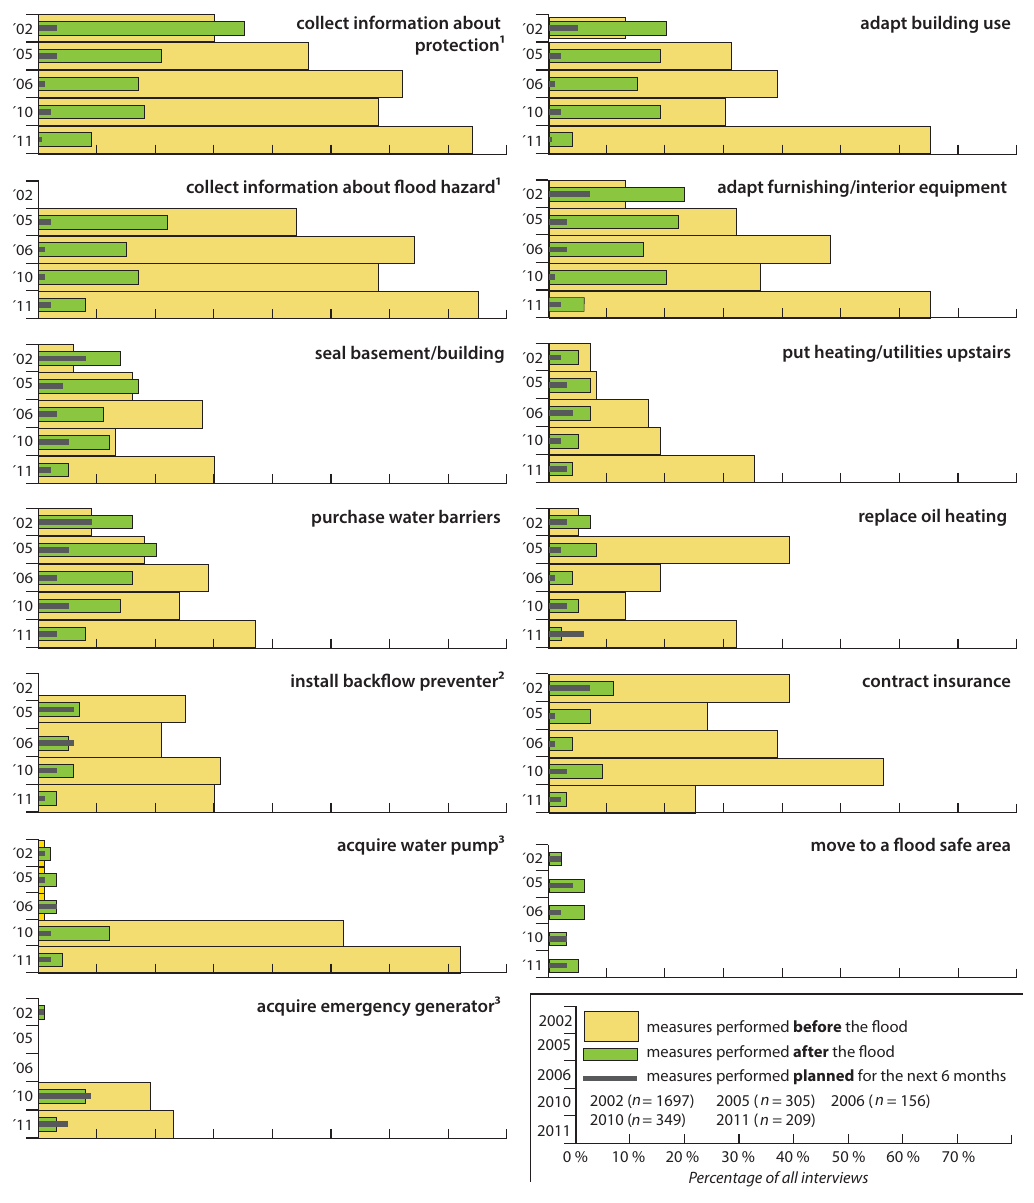
Figure 9. Precautionary measures taken in private households before and after the respective flood events, and measures planned for the next six